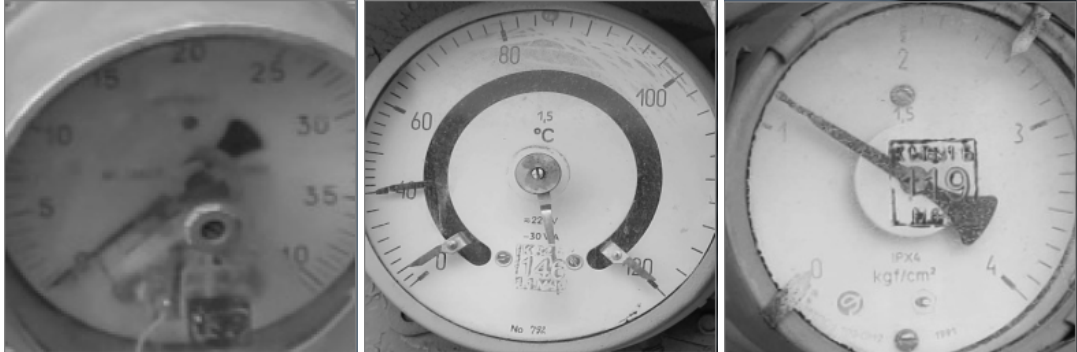
Figure 6. Some examples of the results of the cropping and scaling procedure.